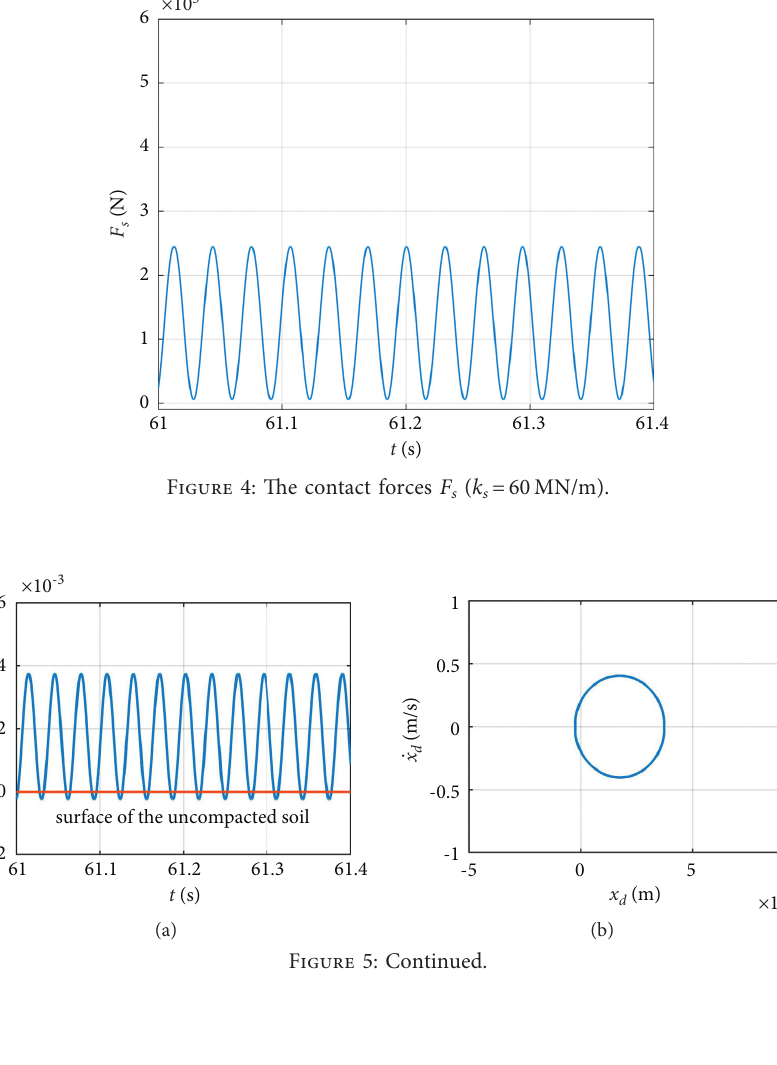
Figure 3: Dynamic responses of the rigid drum ( k Poincare